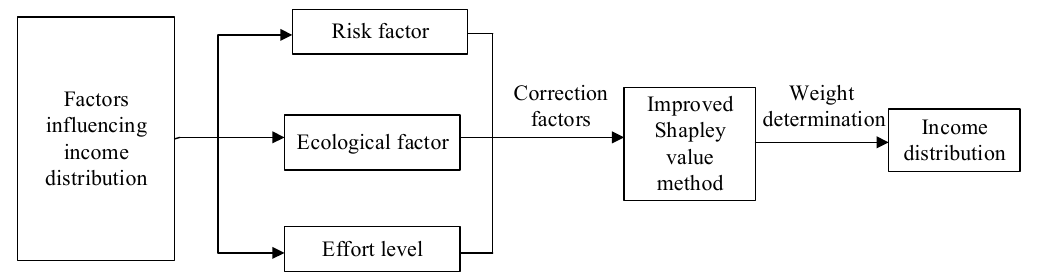
Figure 2. Improved Shapley value method.